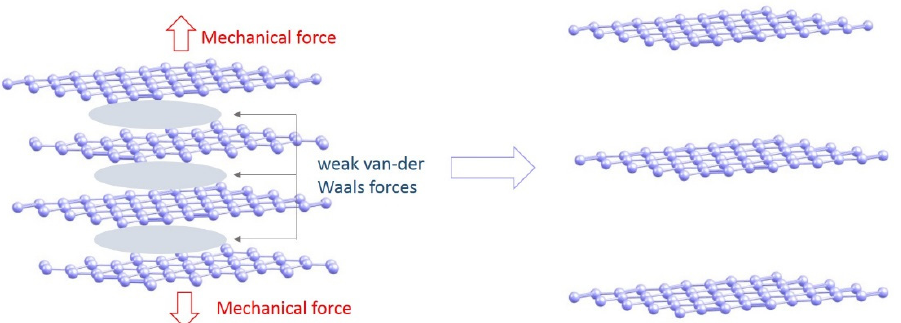
Figure 4. Mechanical exfoliation process in graphite.